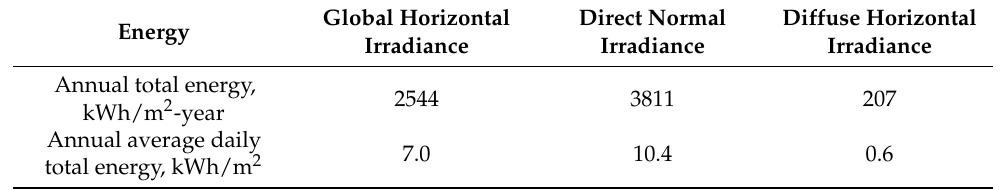
Table 4. Radiation characteristics for the study site (latitude: − 27.7799, longitude: − 69.974)